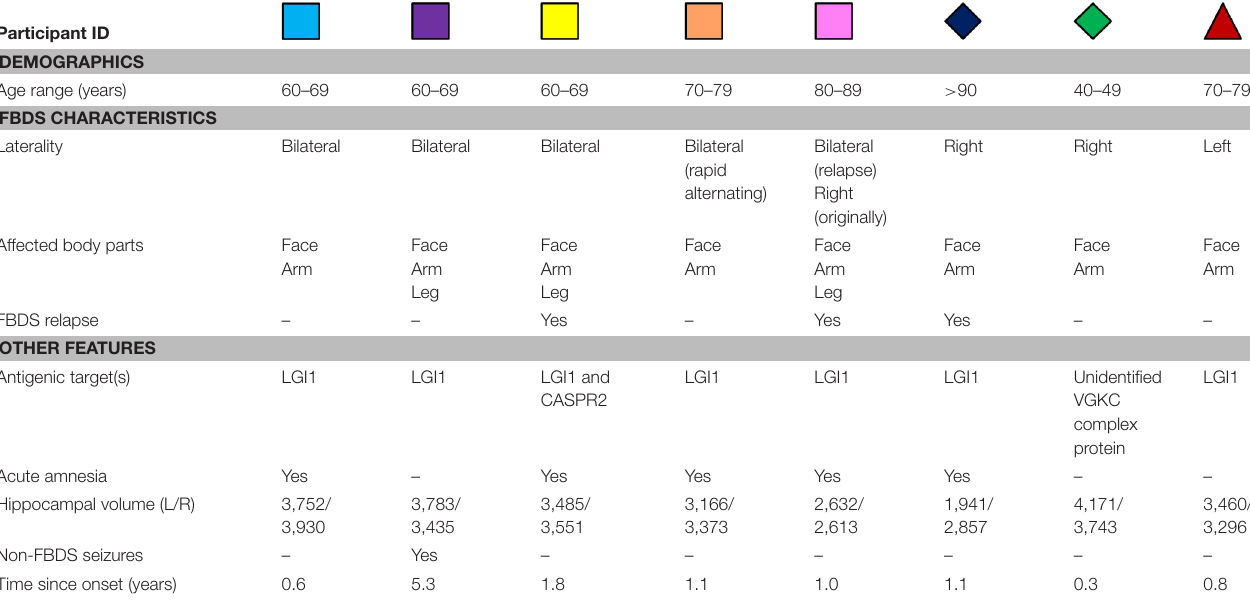
TABLE 1 | Individual demographic and clinical characteristics of participants treated for autoimmune encephalitis with FBDS.